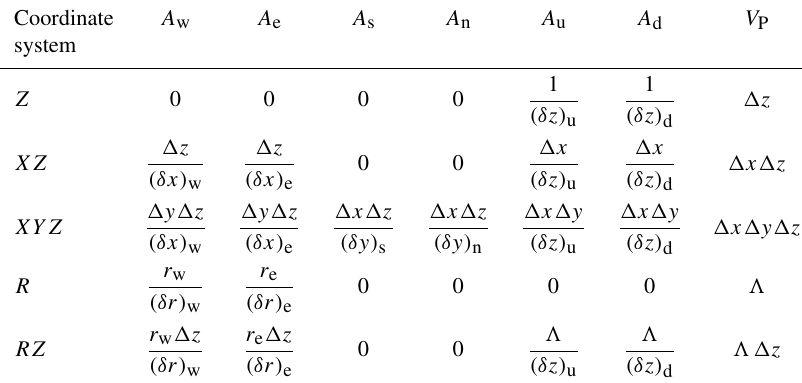
Table 3. Geometric factors A x and V P appearing in the enthalpy discretization (Eq. 39) for Cartesian and cylindrical coordinate systems. Dimensions of the control volume centered on grid point P are (cid:49)x = (x e − x w ) , (cid:49)y = (y n − y s ) , and (cid:49)z = (z d − z u ) , while the distances between grid points in the X direction are (δx) w = (x P − x W ) and (δx) e = (x E − x P ) . Distances between grid points in Y and Z directions are defined similarly. For radial geometries, (cid:51) = (r 2 e − r 2 w )/ 2.